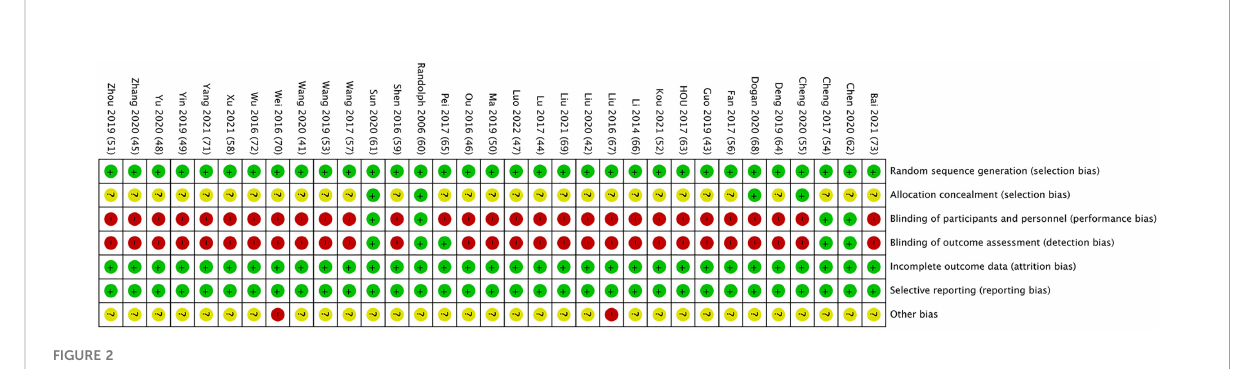
FIGURE 2 Risk of bias assessment by individual